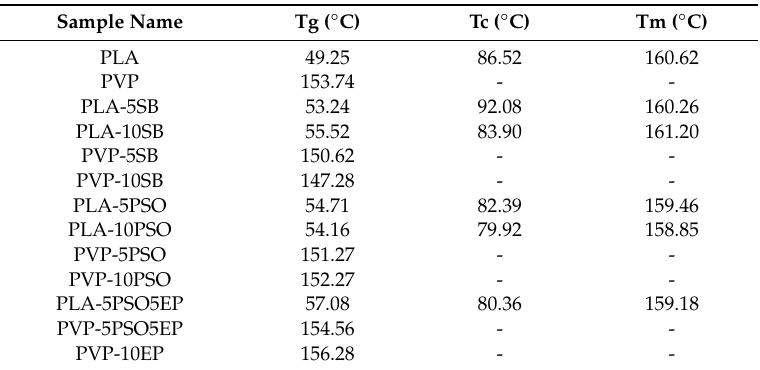
Table 4. Thermal Properties of Prepared Samples.